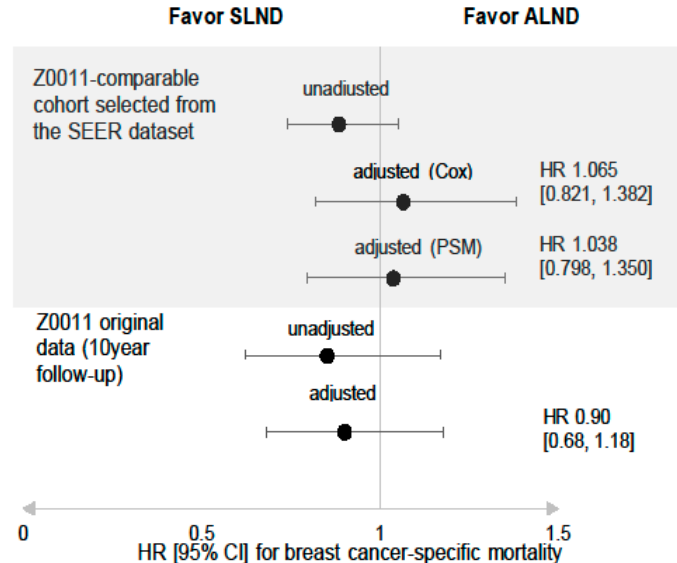
Figure 3. Adjusted hazard ratios of the SLND group to the SLND + ALND group, for breast cancer-specific mortality after propensity score matching. Abbreviations: axillary lymph node (ALN); axillary lymph node dissection (ALND); confidence interval (CI); hazard ratio (HR); sentinel lymph node dissection (SLND).